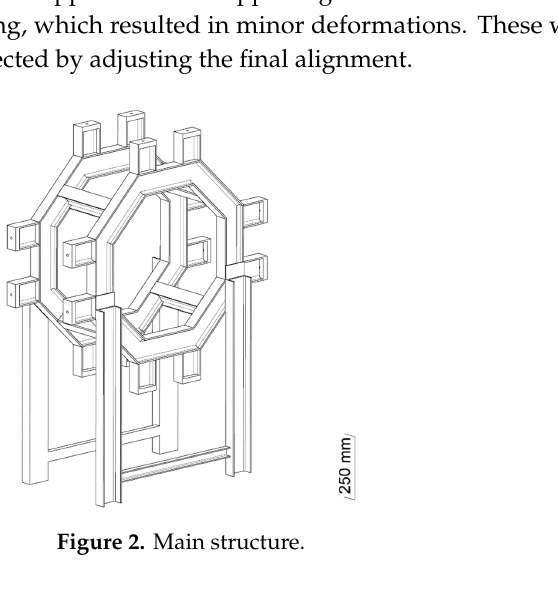
Figure 2. Main structure.